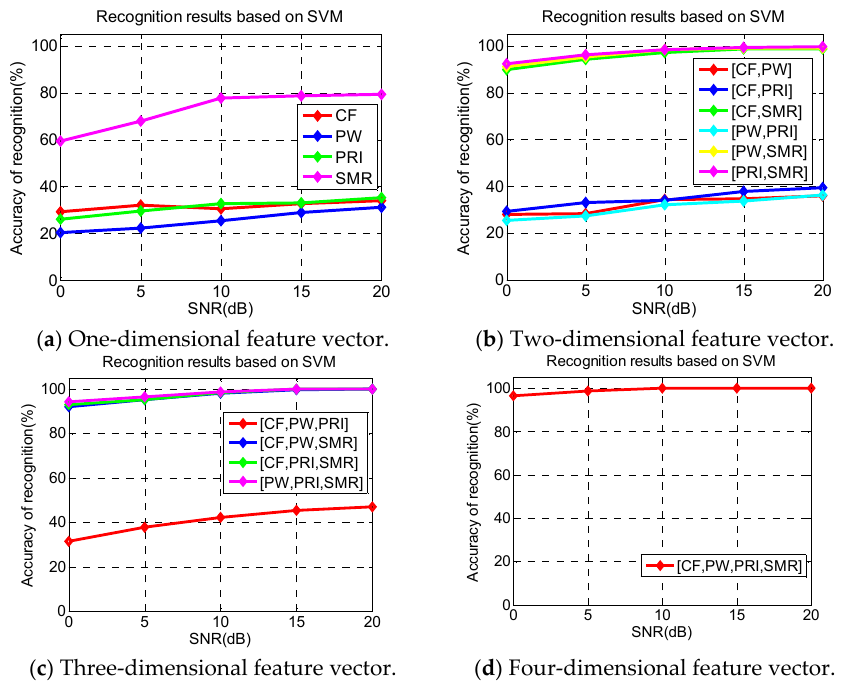
( c ) Three-dimensional feature vector. ( d ) Four-dimensional feature vector. Figure 12. Recognition results of REID based on SVM in different SNRs.